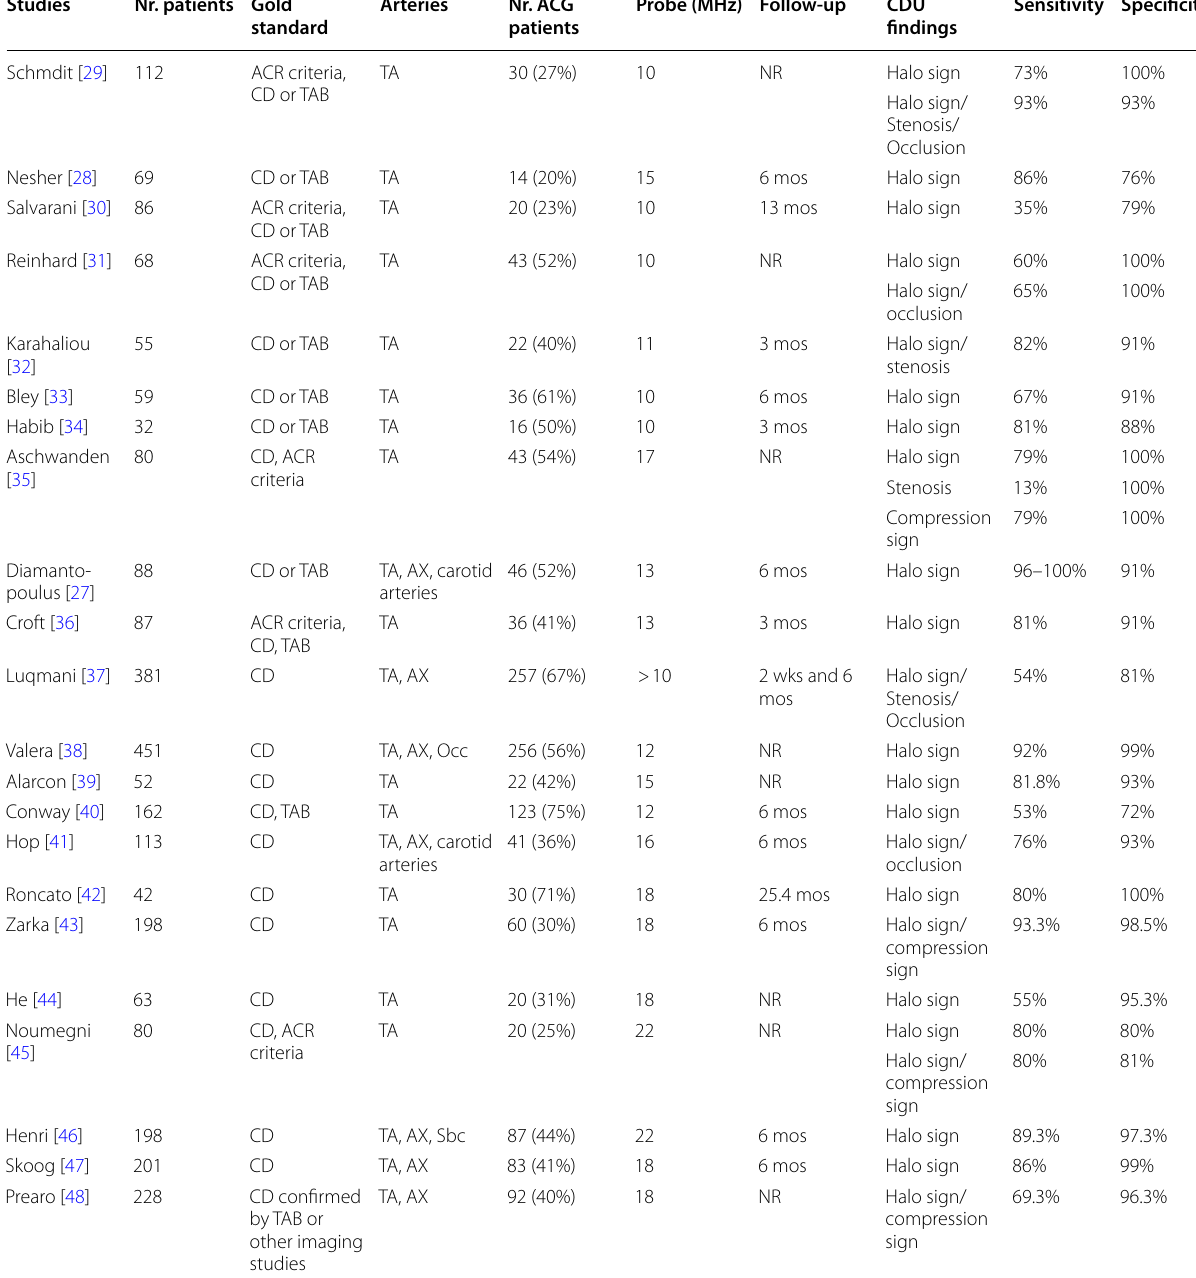
Table 1 Characteristics of GCA diagnostic studies by CDU of temporal arteries using clinical diagnosis as a gold